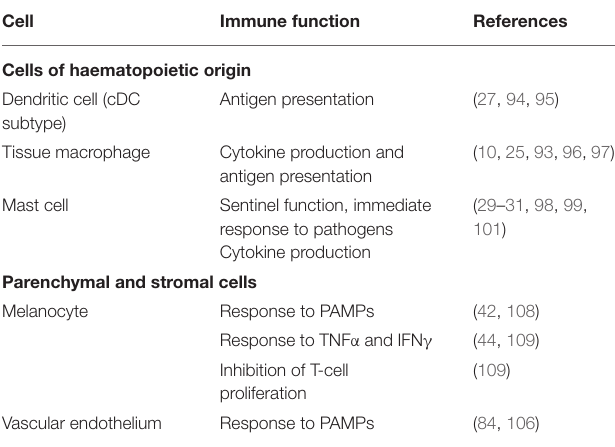
TABLE 3 | Summary table of the immune functions of choroidal cell